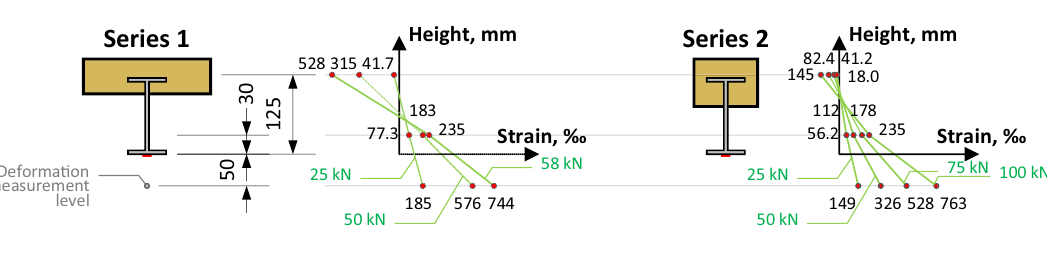
Figure 7. Longitudinal strain distribution in the hybrid